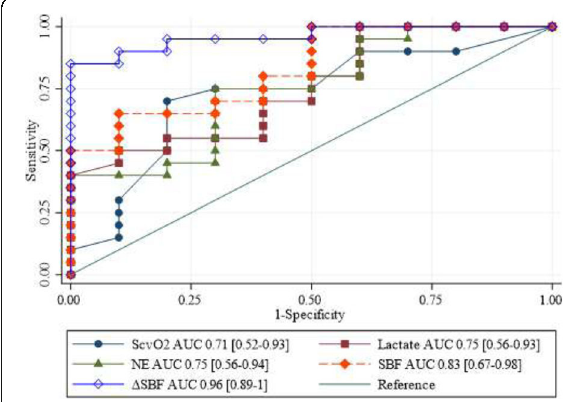
Fig. 1 (abstract 0323). Baseline variables and Δ SBF at H1 to predict Δ L% ≥ 10 during